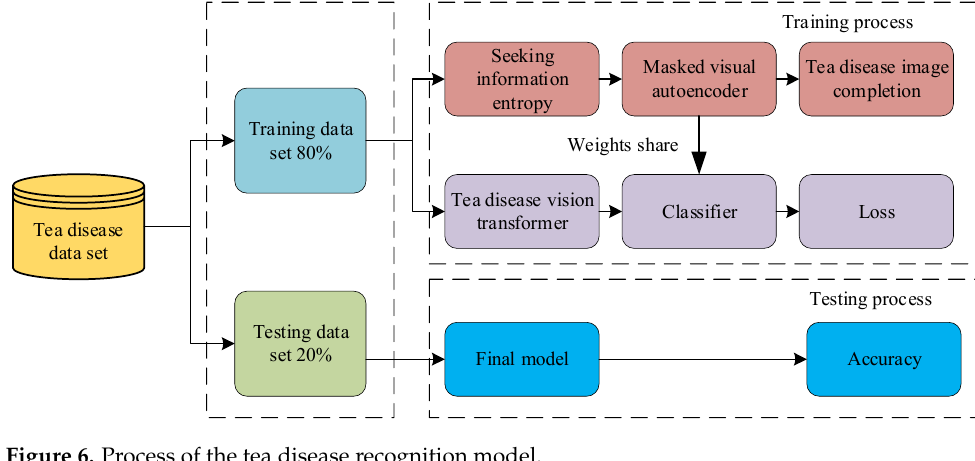
Figure 6. Process of the tea disease recognition model.